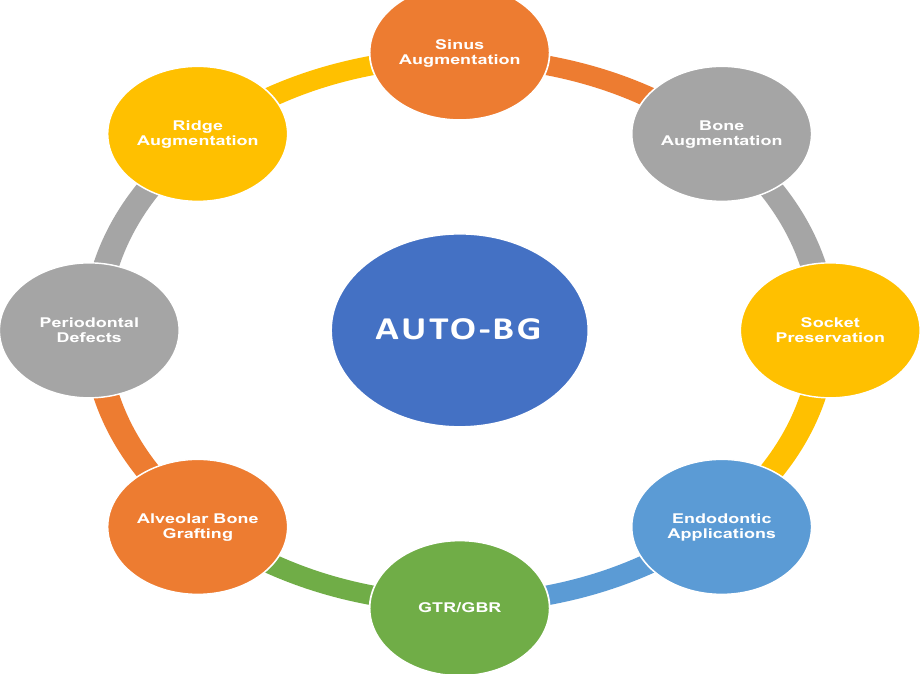
Figure 2. Clinical applications of AUTO-BG.